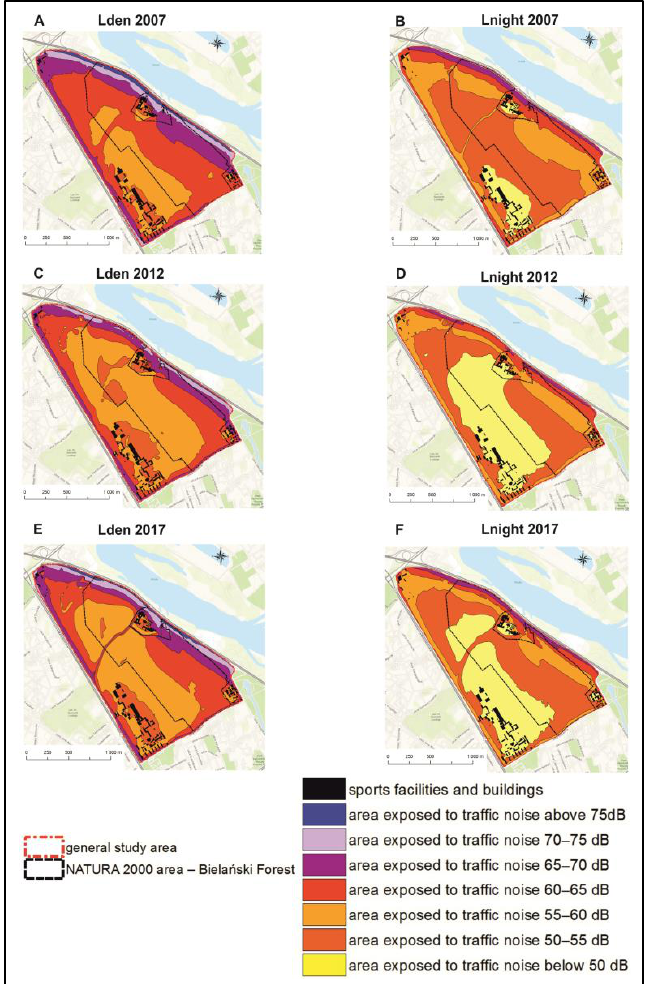
Figure 2. Changes in the areas exposed to road noise, as illustrated by the Lnight and Lden indicators in 2007 ( A , B ), 2012 ( C , D ) and 2017 ( E , F ) within the study area (our own elaboration on the basis of maps of noise pollution in Warsaw). Table 2. Changes in the areas exposed to road noise according to the Lnight and Lden indicators in 2007, 2012 and 2017 in Bielański Forest NATURA 2000 (our own elaboration on the basis of maps of noise pollution in Warsaw).